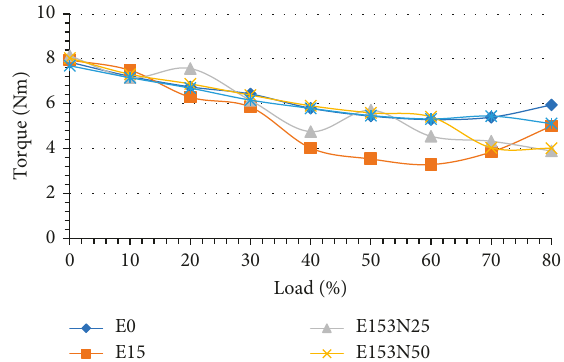
Figure 5: The effect of ethanol amount on engine torque.